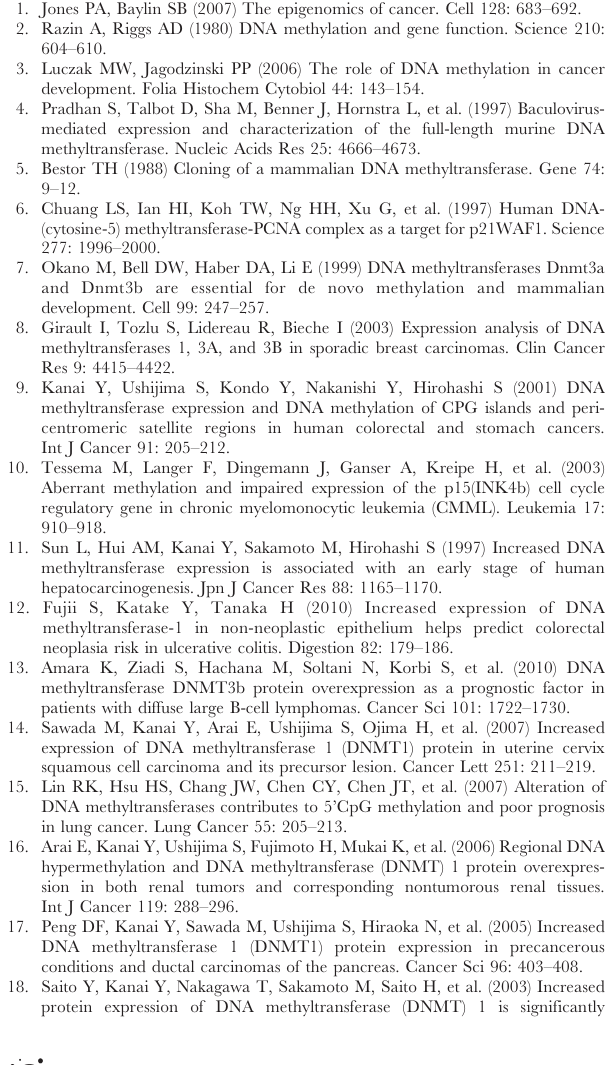
Figure S2 Kaplan-Meier survival analysis of association between DNMT3a expression and OS and DFS in different subgroups. (TIF) Figure S3 Kaplan-Meier survival analysis of association between DNMT3b expression and OS and DFS in different subgroups.